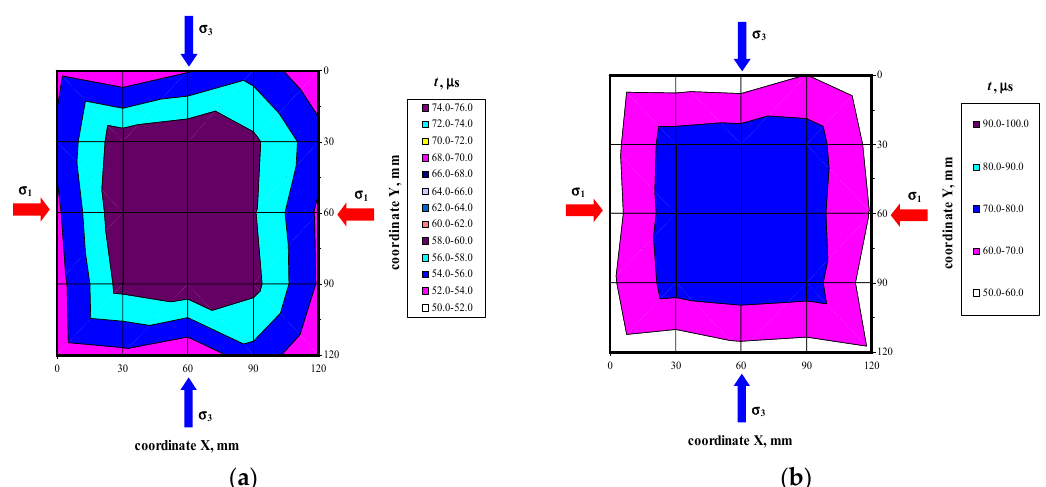
Figure 8. Maps of passing time the ultrasonic wave in the model 600/1 at selected loading levels: ( a ) P = 0, ( b ) P = P max .